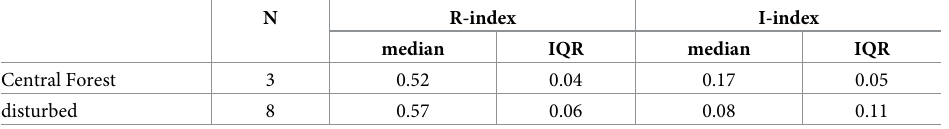
Table 4. R- and I- index median and interquartile range (IQR) for upper 50 cm section in the peat profile for Cen- tral Forest and disturbed sites. © University of Nottingham/ British Geological Survey © UKRI.